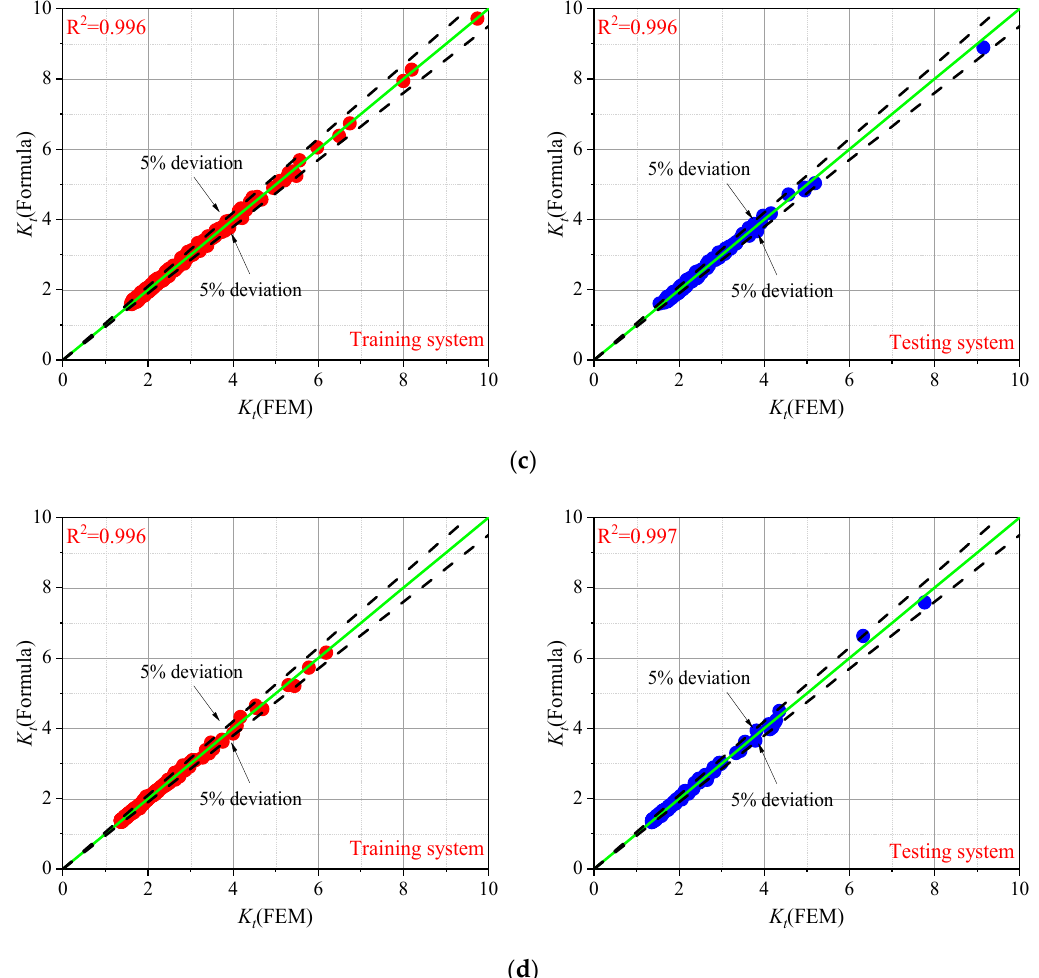
Figure 7. Comparison of SCF determined by FE analysis and proposed parametric formulae: ( a ) T-shape joint under tensile stress ( b ) T-shape joint under bending stress; ( c ) cruciform joint under tensile stress; ( d ) cruciform joint under bending stress.